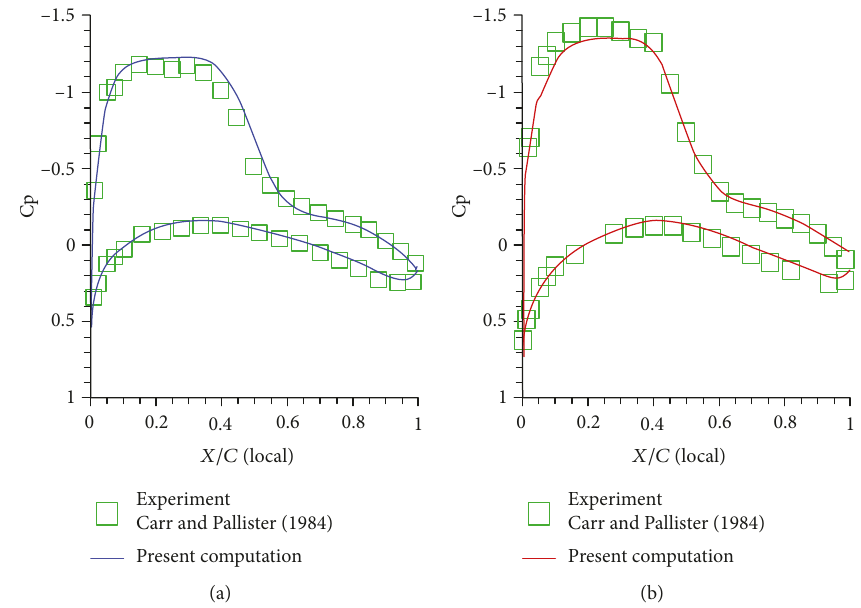
Figure 24: Cp distribution on ARA M100 wing-fuselage con fi guration. M = 0 8027 , α = 2 873 ° , and Re/m = 13 × 10 6 . η = 0 198 (a); η = 0 325